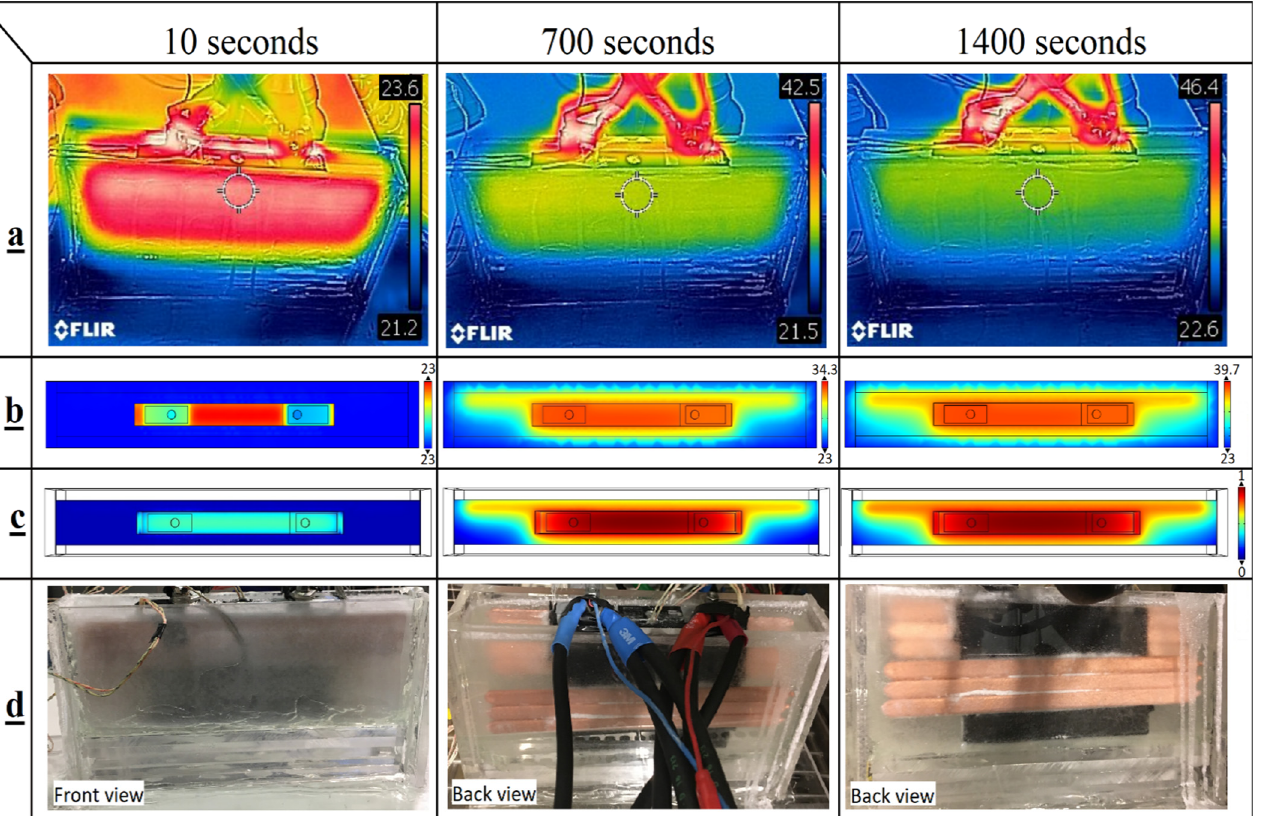
Figure 13. ( a ) Thermal images of the hybrid PCM-heat pipe TMS for the LiC 2300 F cell; ( b ) top view of the cell considering the temperature distribution; ( c ) phase change regions from the liquid phase to the solid phase; ( d ) experimental setup of the system from solid phase to the liquid phase [48].